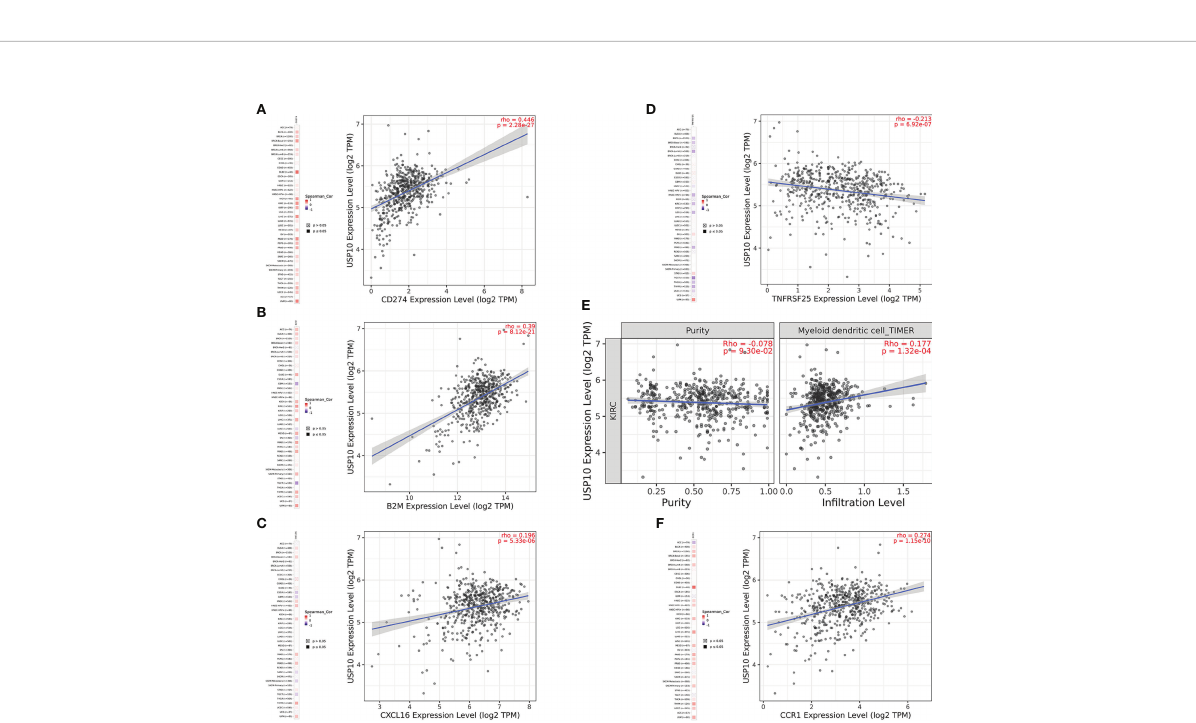
FIGURE 6 USP10 was positively correlated with CD274 (A) , B2M (B) , CXCL16 (C) , myeloid dendritic cell (E) , and CCR1 (F) , but negatively correlated with TNFRSF25 (D) in KIRC. USP10, Ubiquitin-speci fi c peptidase 10; TAP2, transporter associated with antigen processing 2; TGFBR1, transforming growth factor beta receptor 1; HNSC, head and neck squamous cell carcinoma; B2M, b 2-microglobulin; CXCL16, C-X-C motif ligand 16; CCR1, CC Chemokine receptor 1; TNFRSF25, TNF receptor superfamily 25; KIRC, kidney renal clear cell carcinoma.